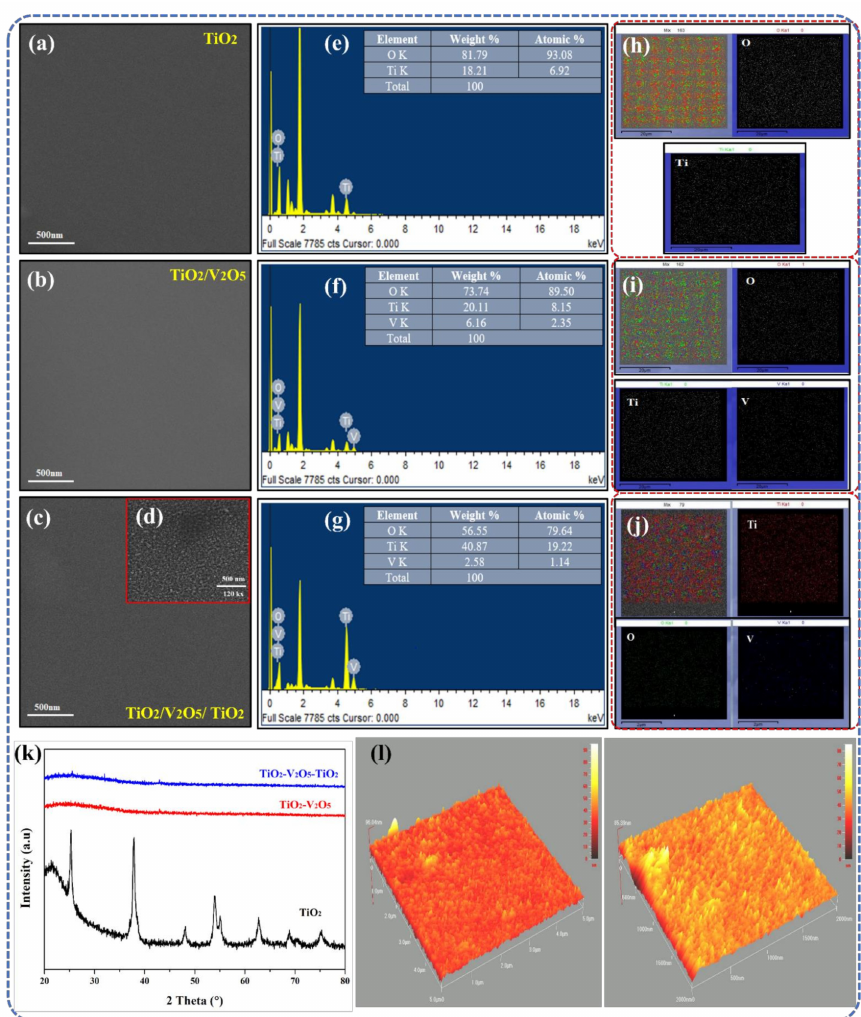
Figure 1. Surface morphology of ( a ) TiO 2 , ( b ) TiO 2 /V 2 O 5 , and ( c ) TiO 2 /V 2 O 5 /TiO 2 at 80 kx magnifi- cation and ( d ) TiO 2 /V 2 O 5 /TiO 2 at 120 kx magnification. EDS analysis and elemental area mapping of ( e , h ) single-layer TiO 2 , ( f , i ) bi-layer TiO 2 /V 2 O 5 , and ( g , j ) multi-layer TiO 2 /V 2 O 5 /TiO 2 thin film. ( k ) XRD analysis of single-, bi-, and tri-layer thin films. ( l ) AFM topography of a multi-layer TiO 2 /V 2 O 5 /TiO 2 thin film on 2 × 2 µ m 2 and 5 × 5 µ m 2 ,